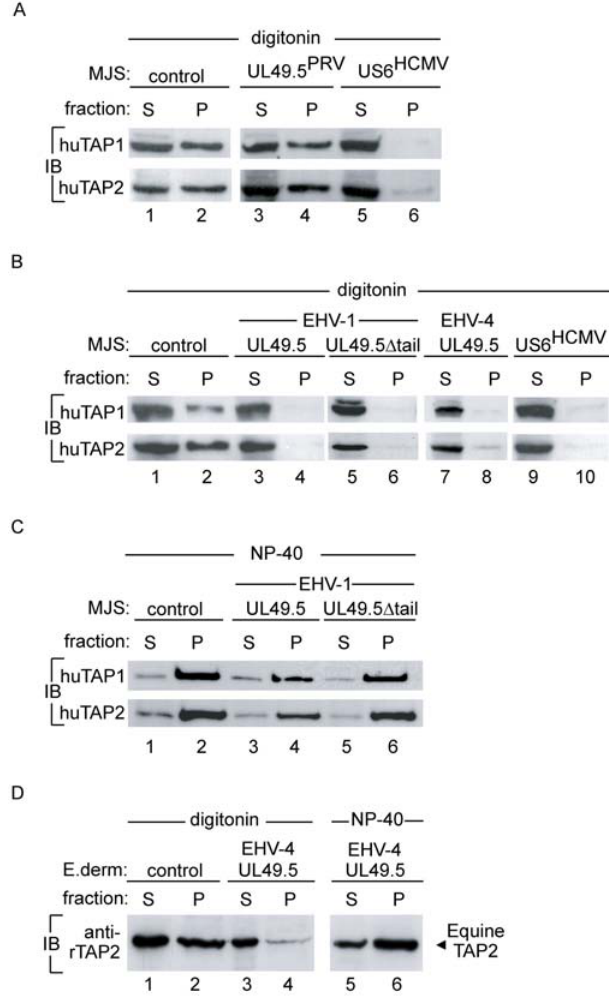
Figure 8. UL49.5 of EHV-1 and EHV-4 block ATP binding to human and equine TAP. (A, B, C) MJS cells expressing the UL49.5 proteins or the HCMV-derived TAP-inhibitor US6 and (D) E.derm cells expressing EHV-4 UL49.5 were lysed using digitonin or NP40 as indicated. Post nuclear lysates were incubated with ATP-agarose. The pellet (P) contains the ATP-binding proteins. The supernatant (S) contains proteins incapable of binding ATP. ATP-bound (ATP-agarose beads; pellet) and unbound (soluble; supernatant) fractions were separated by centrifugation and analyzed using SDS-PAGE and immunoblotting (IB) with antibodies against the proteins indicated.